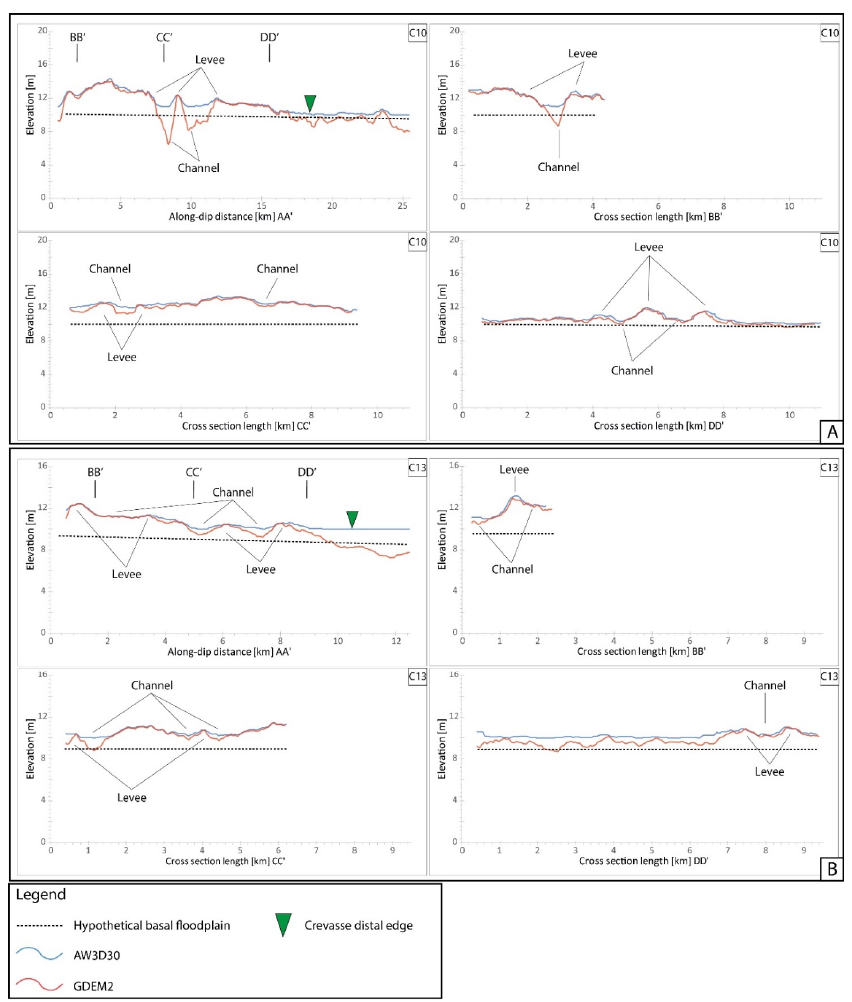
Figure 8. Altimetric profiles based on elevation data of both AW3D30 (blue line) and GDEM2 (red line) datasets. Moving averaged values range from 10 up to 20 m. Location of the profile traces are reported in Figure 6. ( A ) Altimetric profiles for the crevasse C10; ( B ) Altimetric profiles for the crevasse